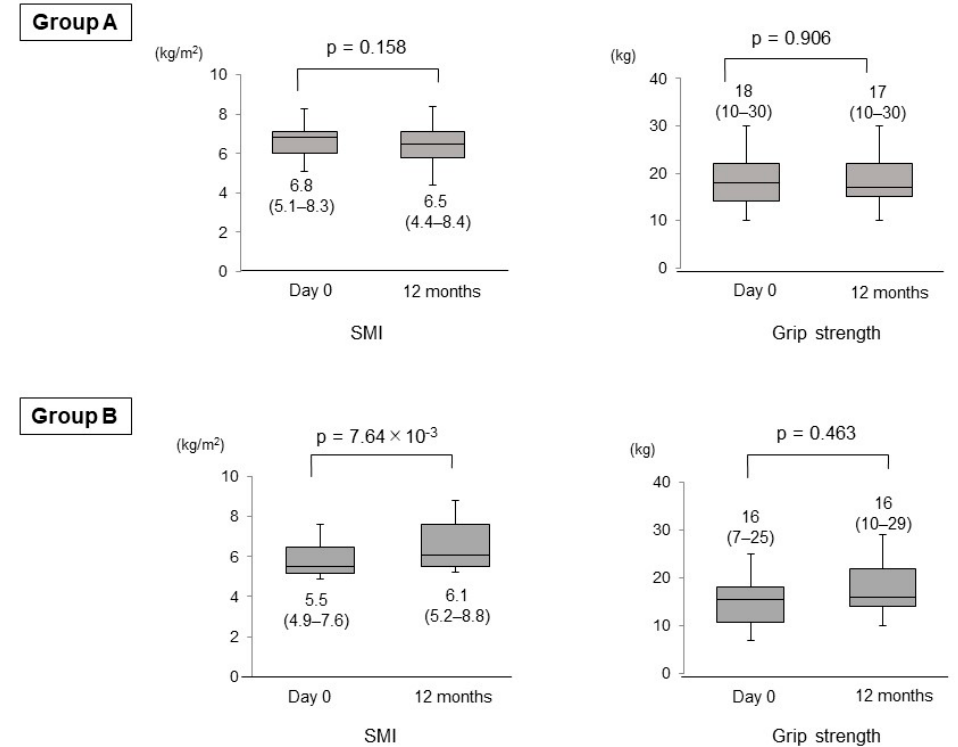
Figure 3. Changes in the skeletal muscle mass index and grip strength between day 0 and 12 months in the untreated ( Group A ) and vitamin D-treated ( Group B ) patients.